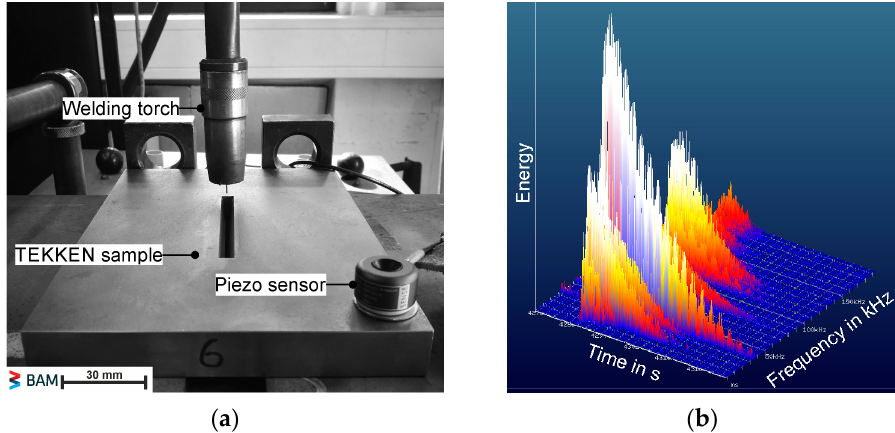
Figure 3. Acoustic emission analysis for in situ monitoring of crack formation: ( a ) Piezo sensor placed on TEKKEN sample; ( b ) Exemplary image of a crack-typical signal 5 min after welding was finished at α = 60°.